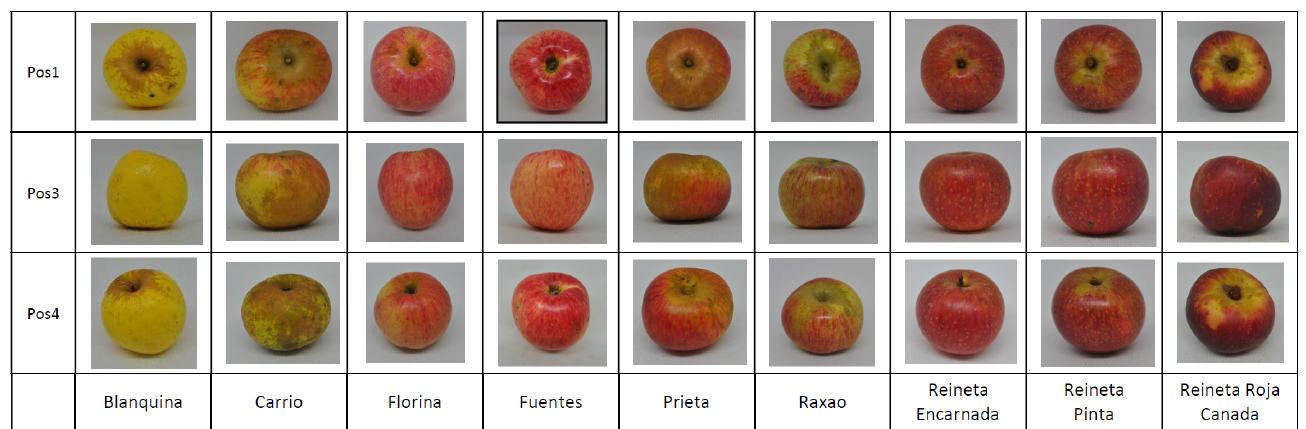
Figure 6. Sample images of apple varieties photographed from different positions (Pos1, Pos3 and